Question: What style of plot is this figure drawn as?
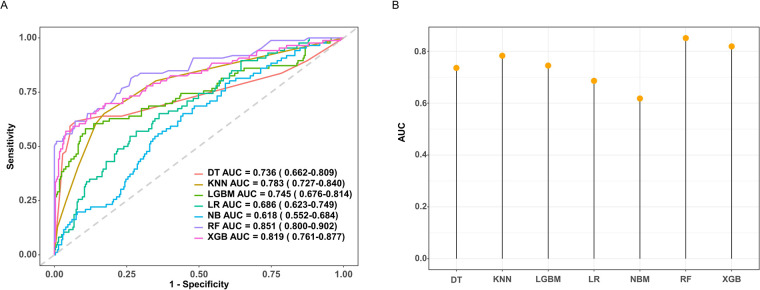
Answer: line